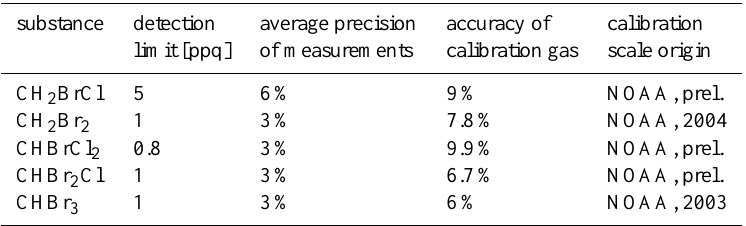
Table 3. Overview of the detection limits and measurement precision of the WASP and the origin and accuracy of the calibration scales used for the various brominated substances. The accuracies are updated from Wisher et al. (2013).